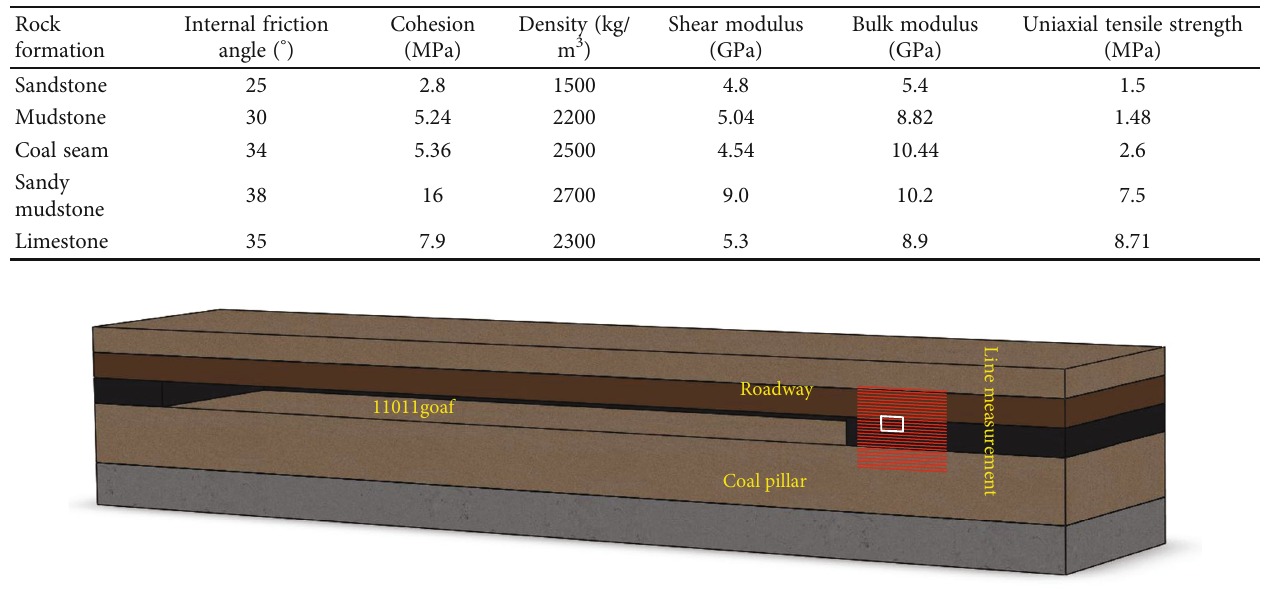
Figure 3: Layout of measuring line in principal stress direction of roadway surrounding